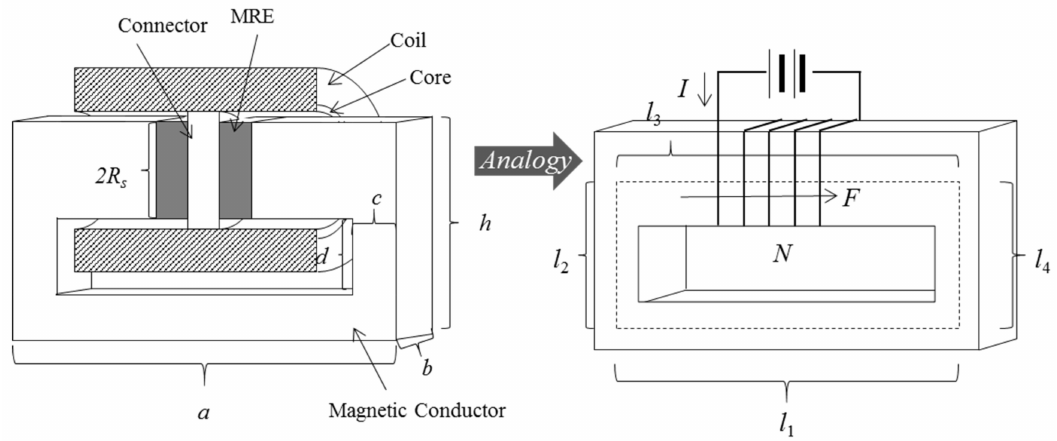
Figure 14. Magnetic circuit analogy model of adaptive tuned MRE vibration